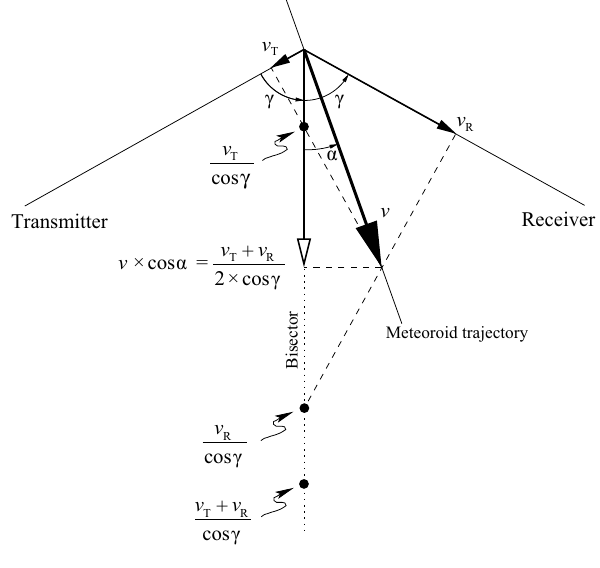
Fig. 2. The Doppler frequency at a remote receiver is propor- tional to v T + v R . The velocity component along the bisector is ( v T + v R ) / (2 × cos γ ) .